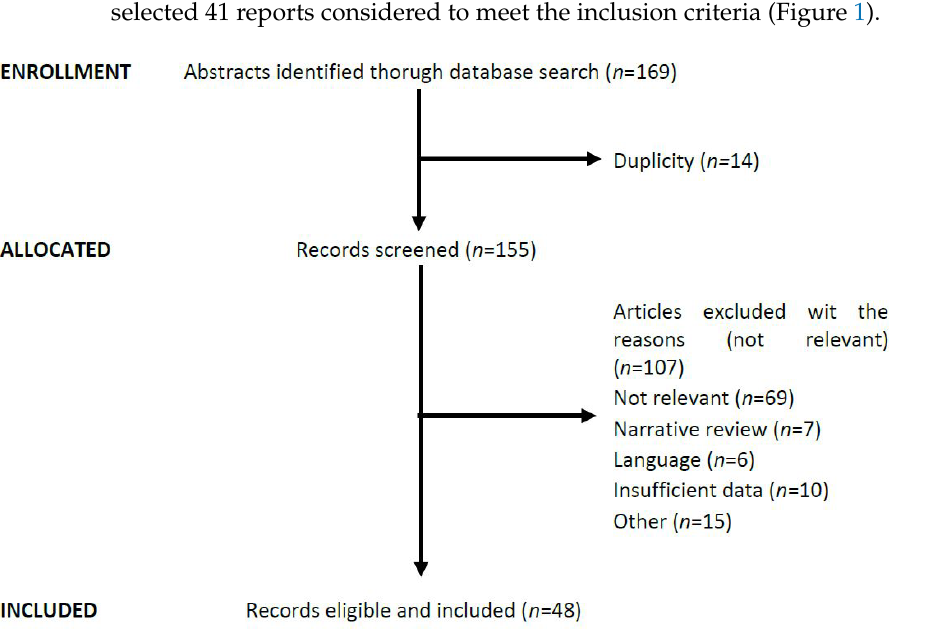
Figure 1. Flowchart describing the identification and inclusion of studies.